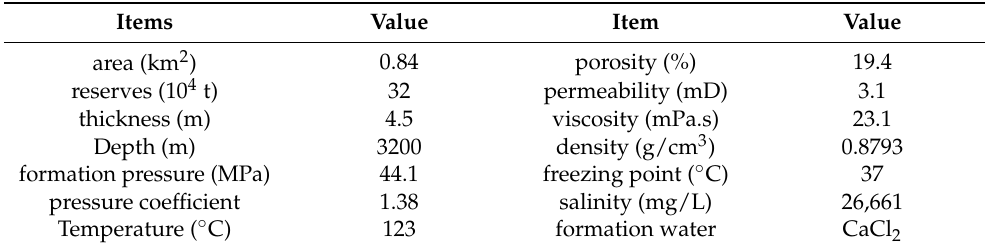
Table 5. Parameters of the real reservoir